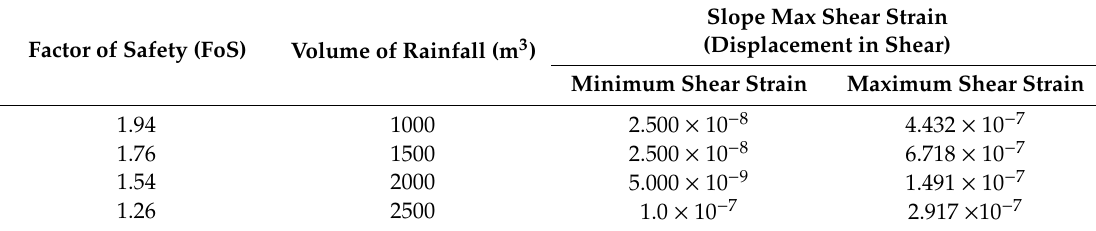
Table 6. General results of FLACSlope simulations in clay soil slope.